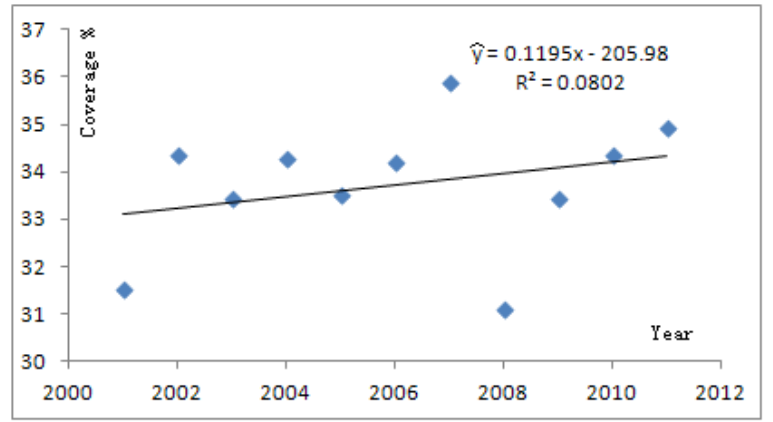
Figure 5. Forest coverage changes in China over the past 11